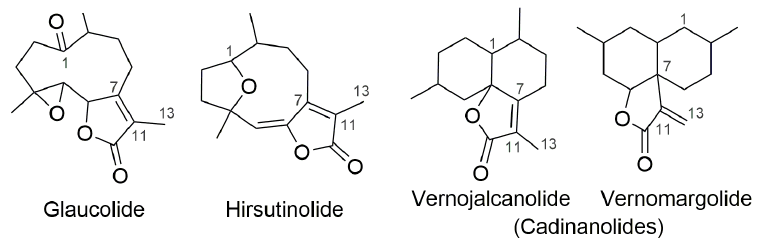
Figure 1. Carbocyclic skeletons of sesquiterpene lactone subtypes.